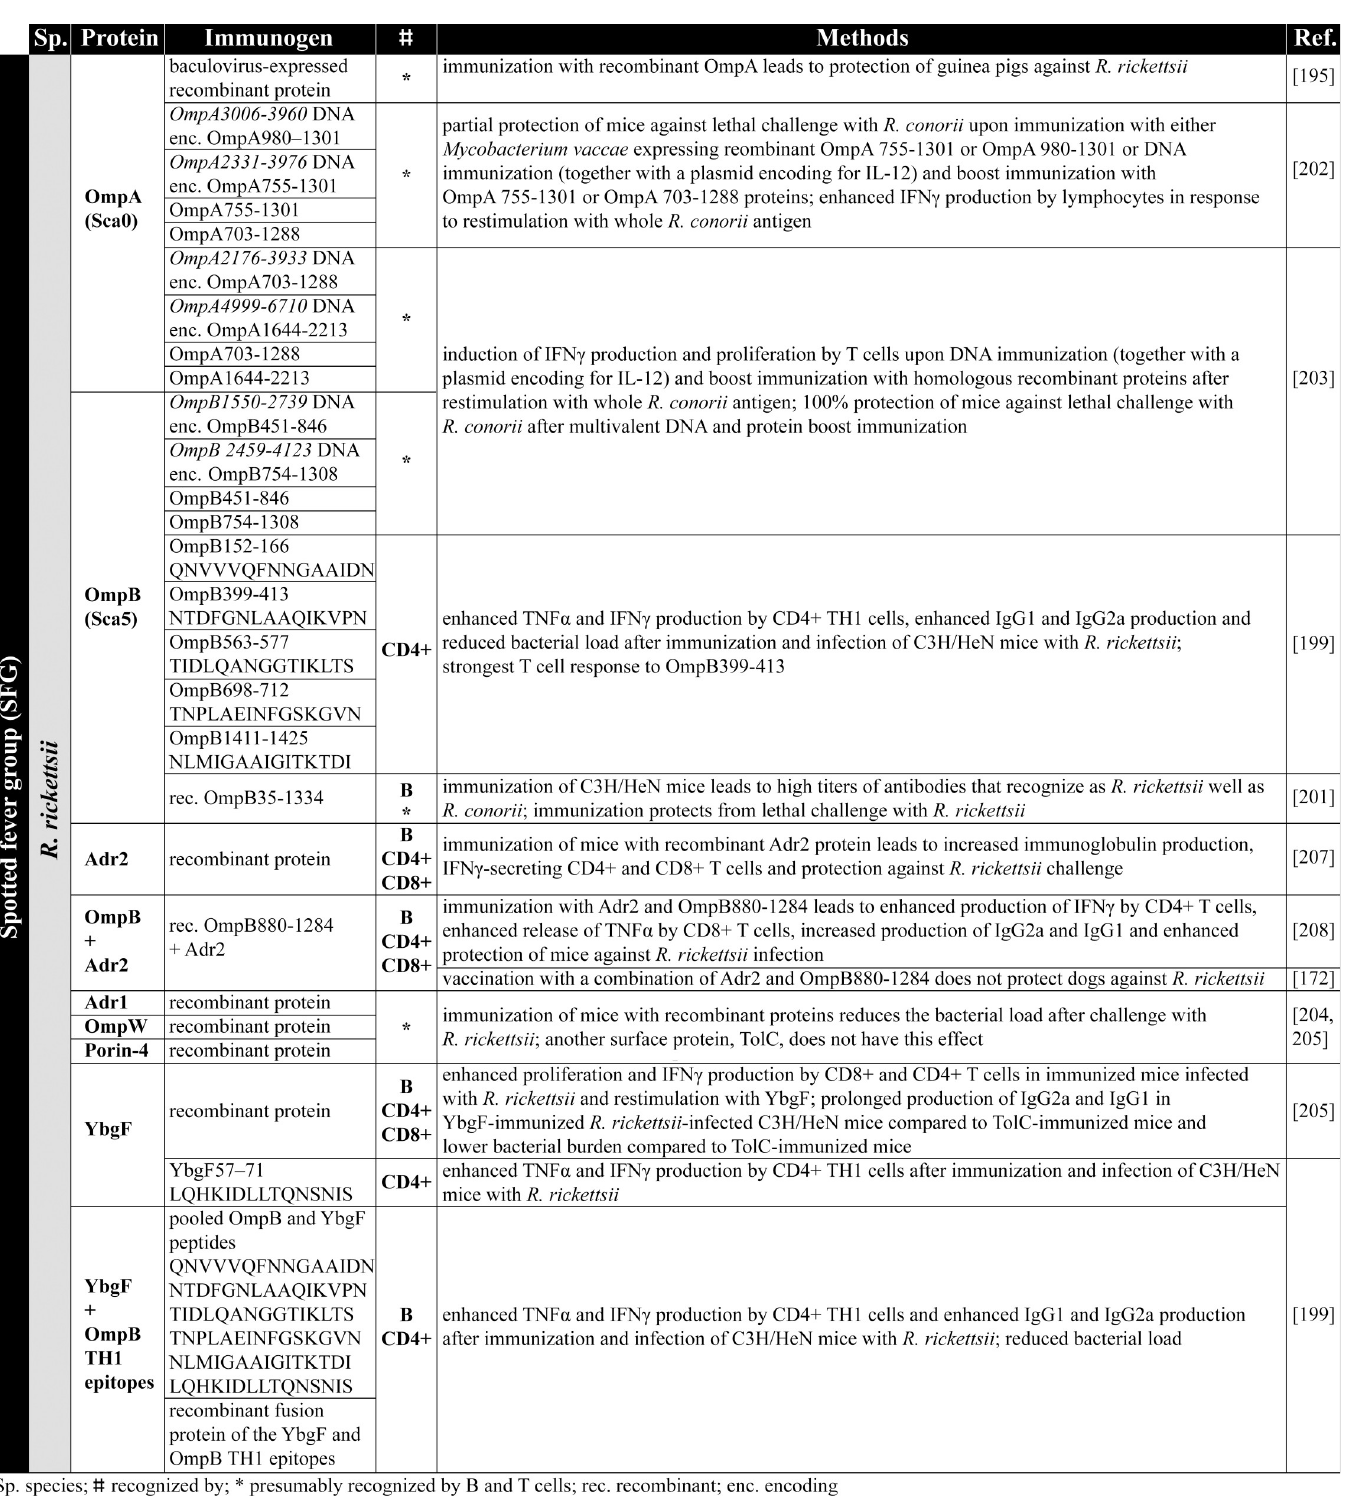
Fig 3. SFG antigens. The figure summarizes the antigens identified from SFG rickettsiae ( R . rickettsii ) [172,195,199,201–205,207,208]. enc., encoding; IFN γ , interferon gamma; IgG1, immunoglobulin G1; IgG2a, immunoglobulin G2a; IL-12, interleukin 12; rec., recombinant; SFG, spotted fever group; TNF α , tumor necrosis factor alpha.